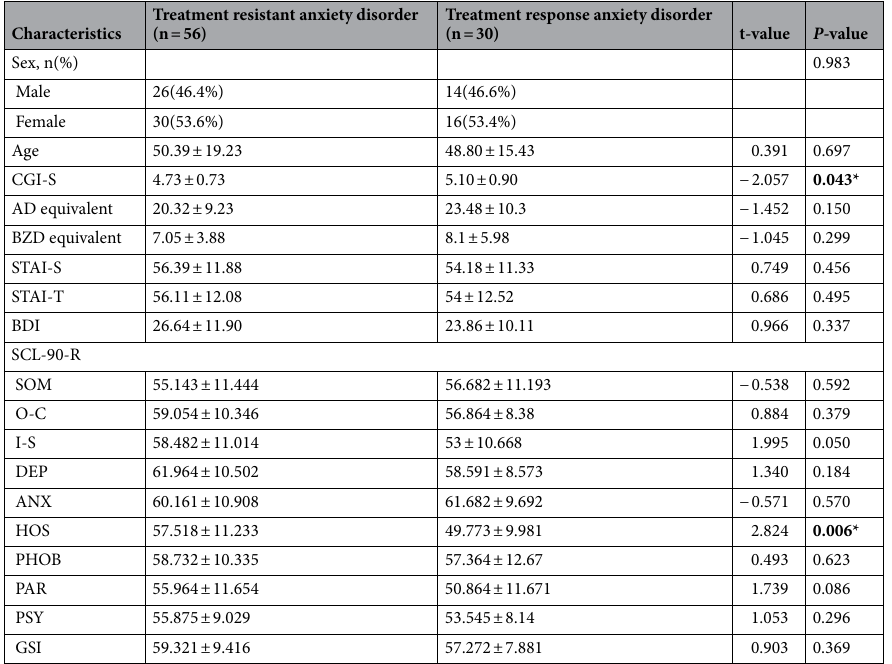
Table 1. Clinical characteristics in each group. * p < 0.05. CGI-S clinical global impression-severity, AD : antidepressant, BZD benzodiazepine, STAI-S state-trait anxiety inventory-state, STAI-T state-trait